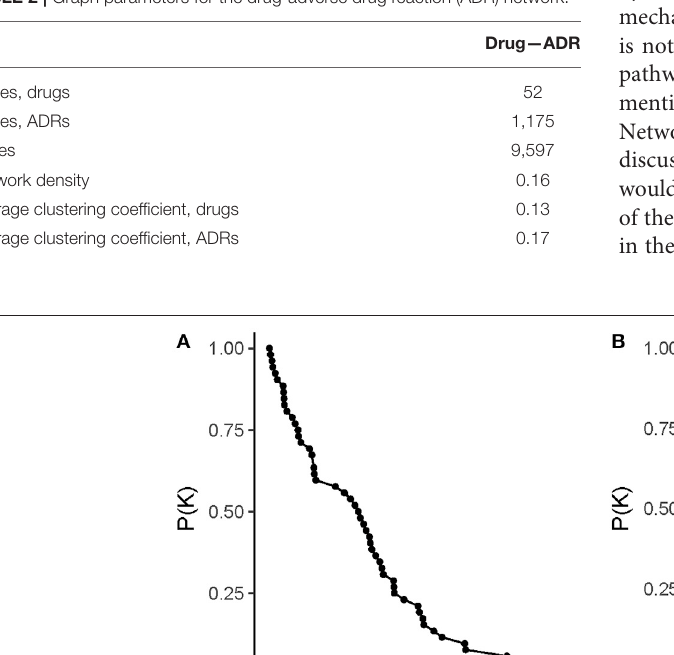
TABLE 2 | Graph parameters for the drug-adverse drug reaction (ADR) network.